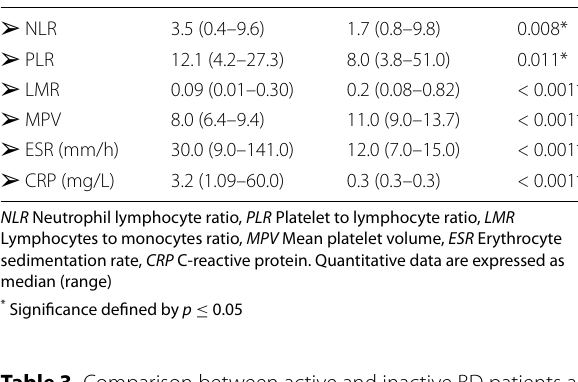
Table 3 Comparison between active and inactive BD patients as regards studied laboratory data